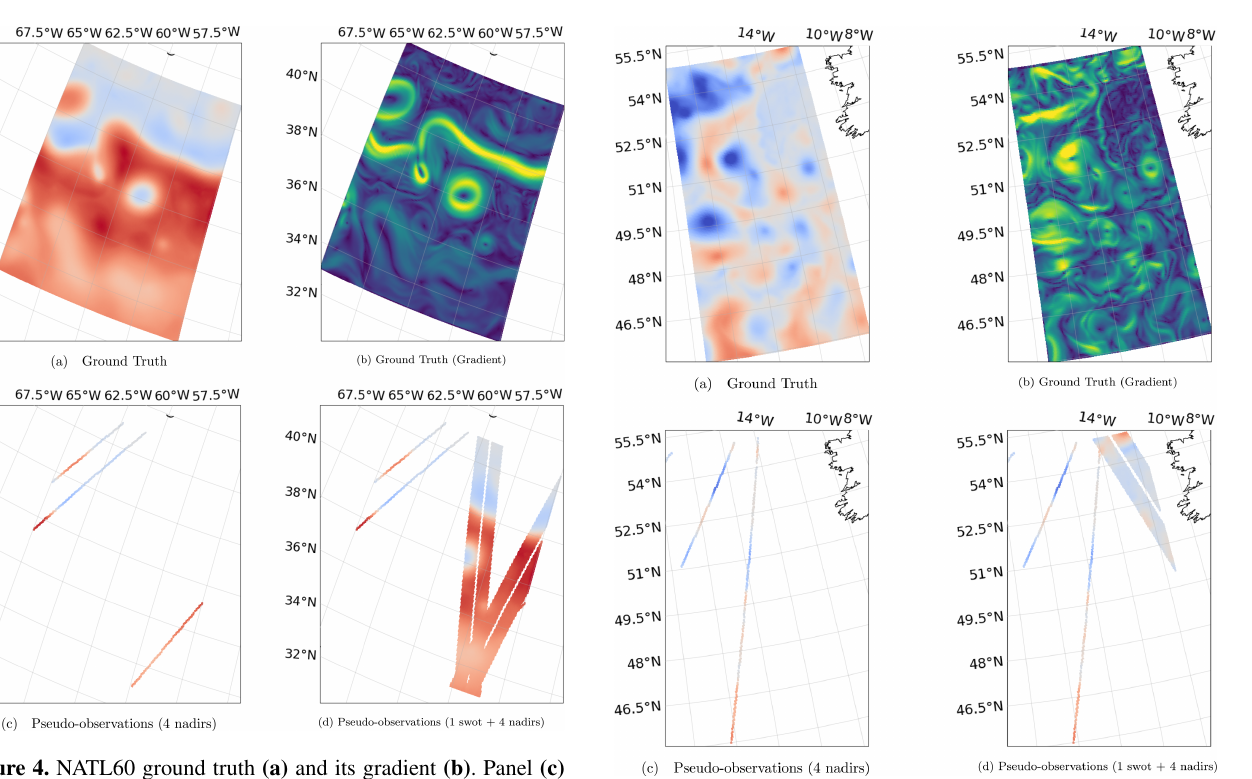
Figure 5. NATL60 ground truth (a) and its gradient (b) . Panel (c) shows 1d accumulated along-track four nadirs, and wide-swath SSH pseudo-observations plus four nadirs are shown in panel (d) , both for 25 October 2012 (OSMOSIS